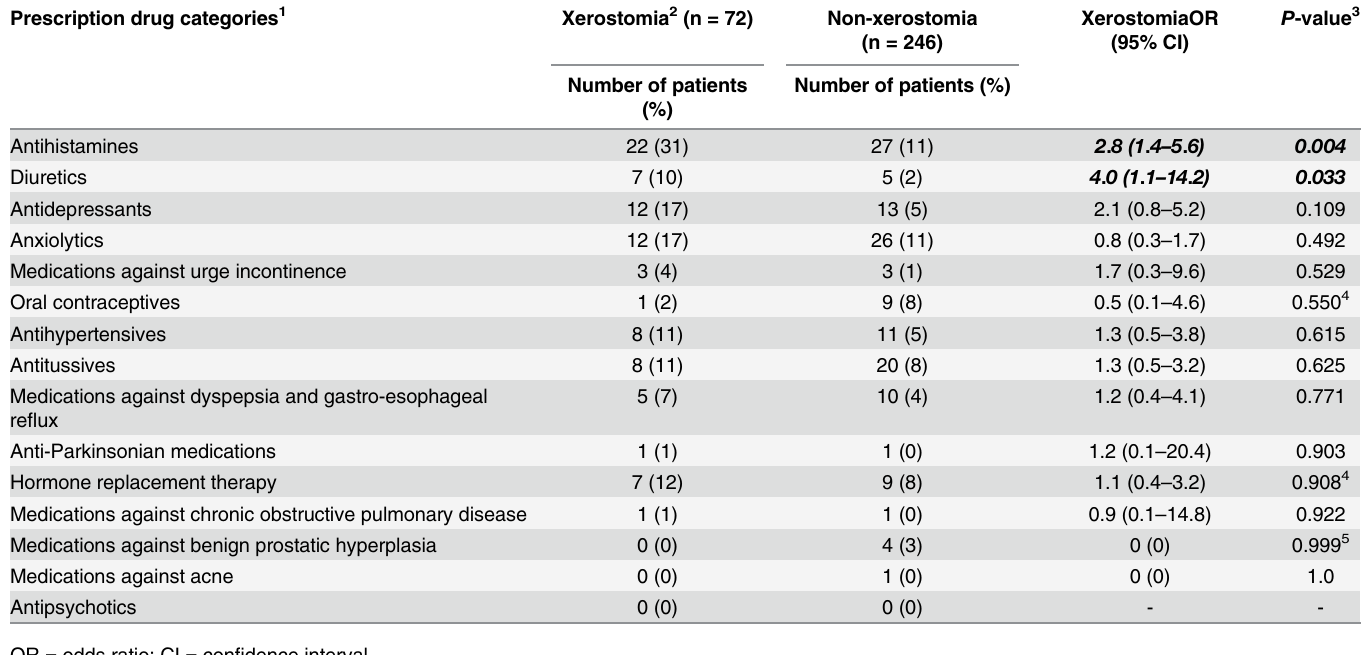
Table 3. Prescription drug categories used in xerostomia and non-xerostomia